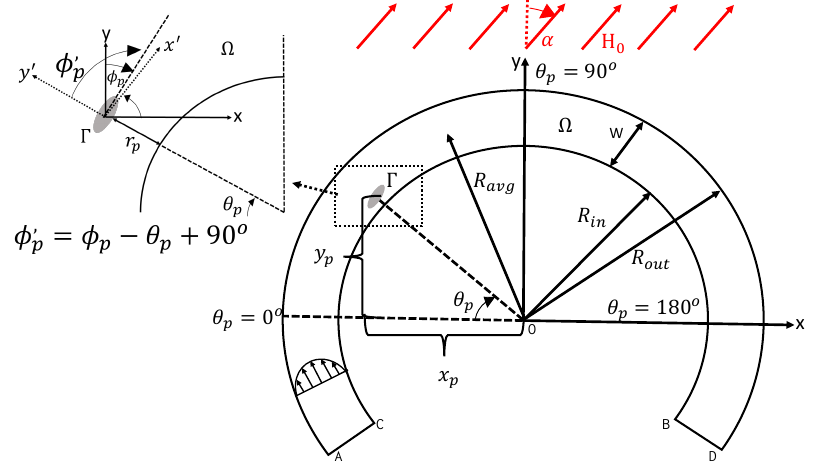
Figure 1. Schematic view of the numerical model of an elliptical particle that is neutrally buoyant in a Poiseuille flow and under a uniform magnetic field with strength H 0 and applied at direction α . The fluid and particle domains are Ω and Γ , respectively. The orientation of the particle is denoted as φ (cid:48) p = φ p − θ p + 90 ◦ such that the laboratory frame is the x (cid:48) − y (cid:48) axes, and y (cid:48) is perpendicular to the channel wall, where φ p is the global direction of the particle ( x − y axes), and θ p is the particle position inside the channel with respect to the origin of both curves, O. The particle-wall separation distance is denoted by r p , and the channel geometry of the curve is denoted by the average radius R avg = R in + R out